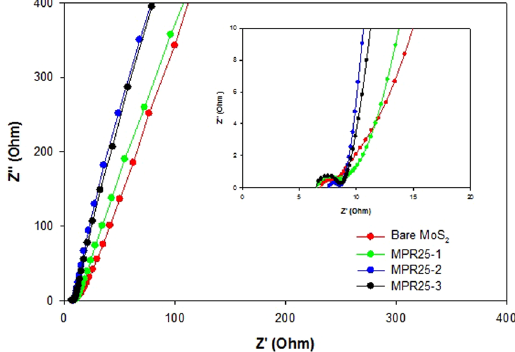
Figure 8. Nyquist plot of bare MoS 2 and composites. The inset shows the magnification of the high-frequency region of the spectra.